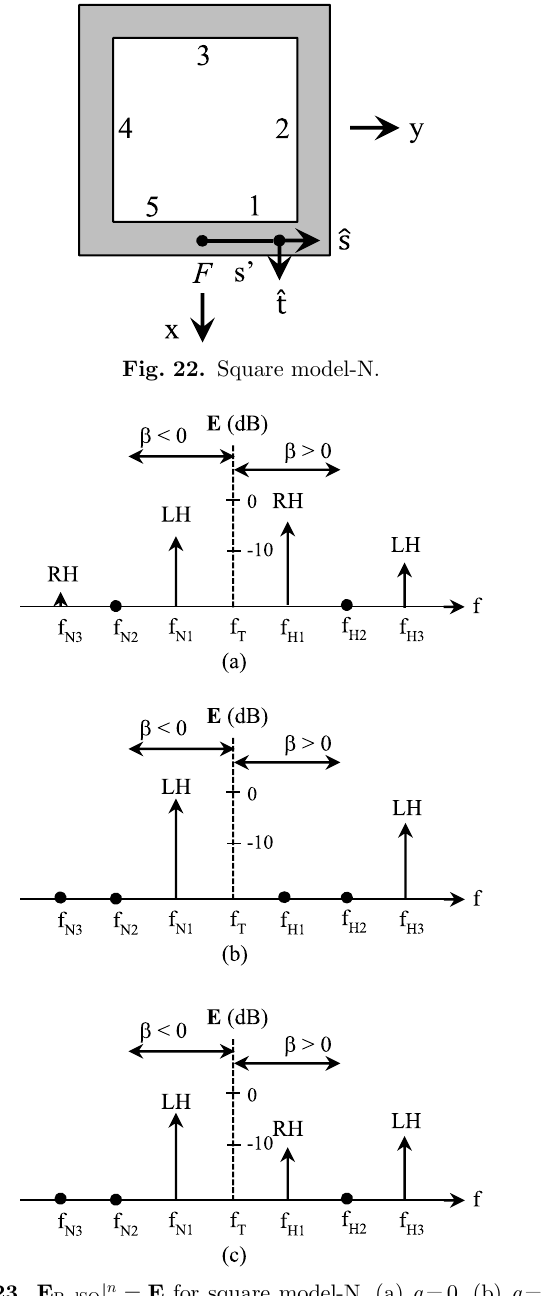
Fig. 22. Square model-N.